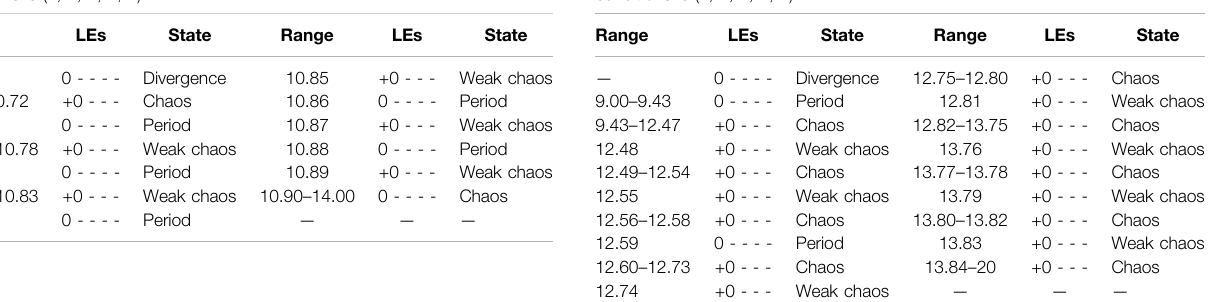
TABLE 1 | System state corresponding to different parameter a when the original conditions is (1, 1, 1, 1, 1). Range